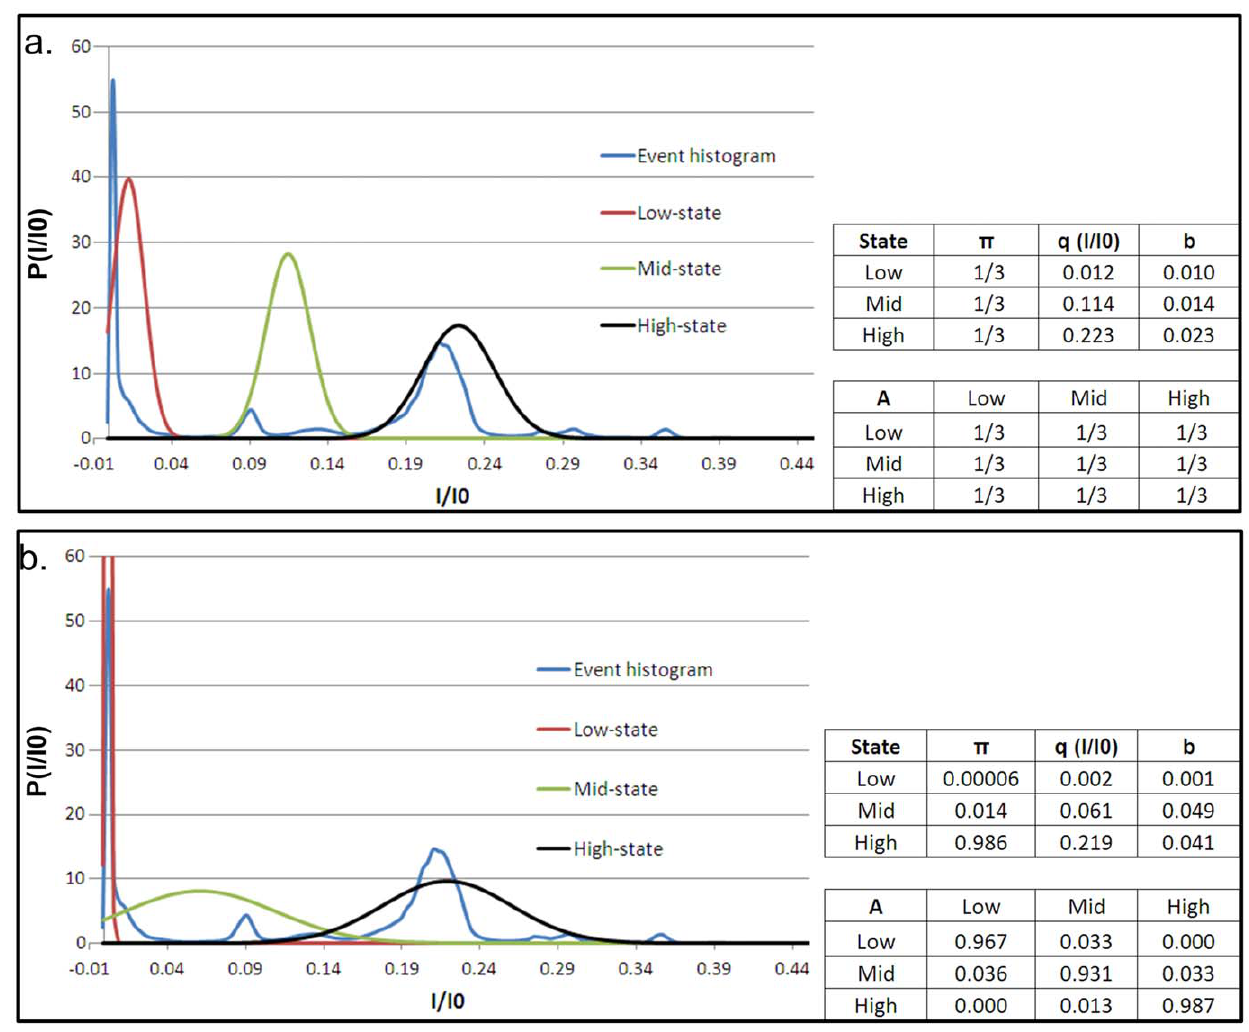
Figure 4. KKRR-ShPrP(120–232) event histogram and initial and optimal HMM models. ( a ) (Left) The KKRR-ShPrP(120–232) event histogram (blue) is divided into three regimes/states a high-state (black), mid-state (green) and low-state (red). The location of the peak and width of the distribution for each state in our initial model represents our best guess of the location and size of a given regime. (Right) The model parameters: p (i.e. the initial condition or probability that an event begins in a given state), q (the location of the peak of the Gaussian distribution, in terms of I/I0, for a given state), b (the standard deviation on the Gaussian of each state, which defines a state’s noise properties), and A (the state-to- state transition probability matrix). In our initial model we assume ignorance of the probabilities and therefore assume p to be uniformly distributed (i.e. an event is assumed equally likely to begin in any of the three states). Similarly with the transition probability matrix A , we assume all transitions to be equally likely (e.g. if in the low-state there is an equal probability for remaining in the low-state as there is for transitioning into the mid-state or the high-state). ( b ) (Left) After 40 iterations of the EM algorithm the optimal three-state model that best describes the data (i.e. the maximum likelihood model estimate) is converged upon. The low-state, far from encompassing all of the low current (as was presumed in our initial model) is very narrow and well defined, while the mid and high states both broaden out (the peak of the mid-state also shifts to a deeper conductance level relative to the initial model). (Right) The corresponding optimal model